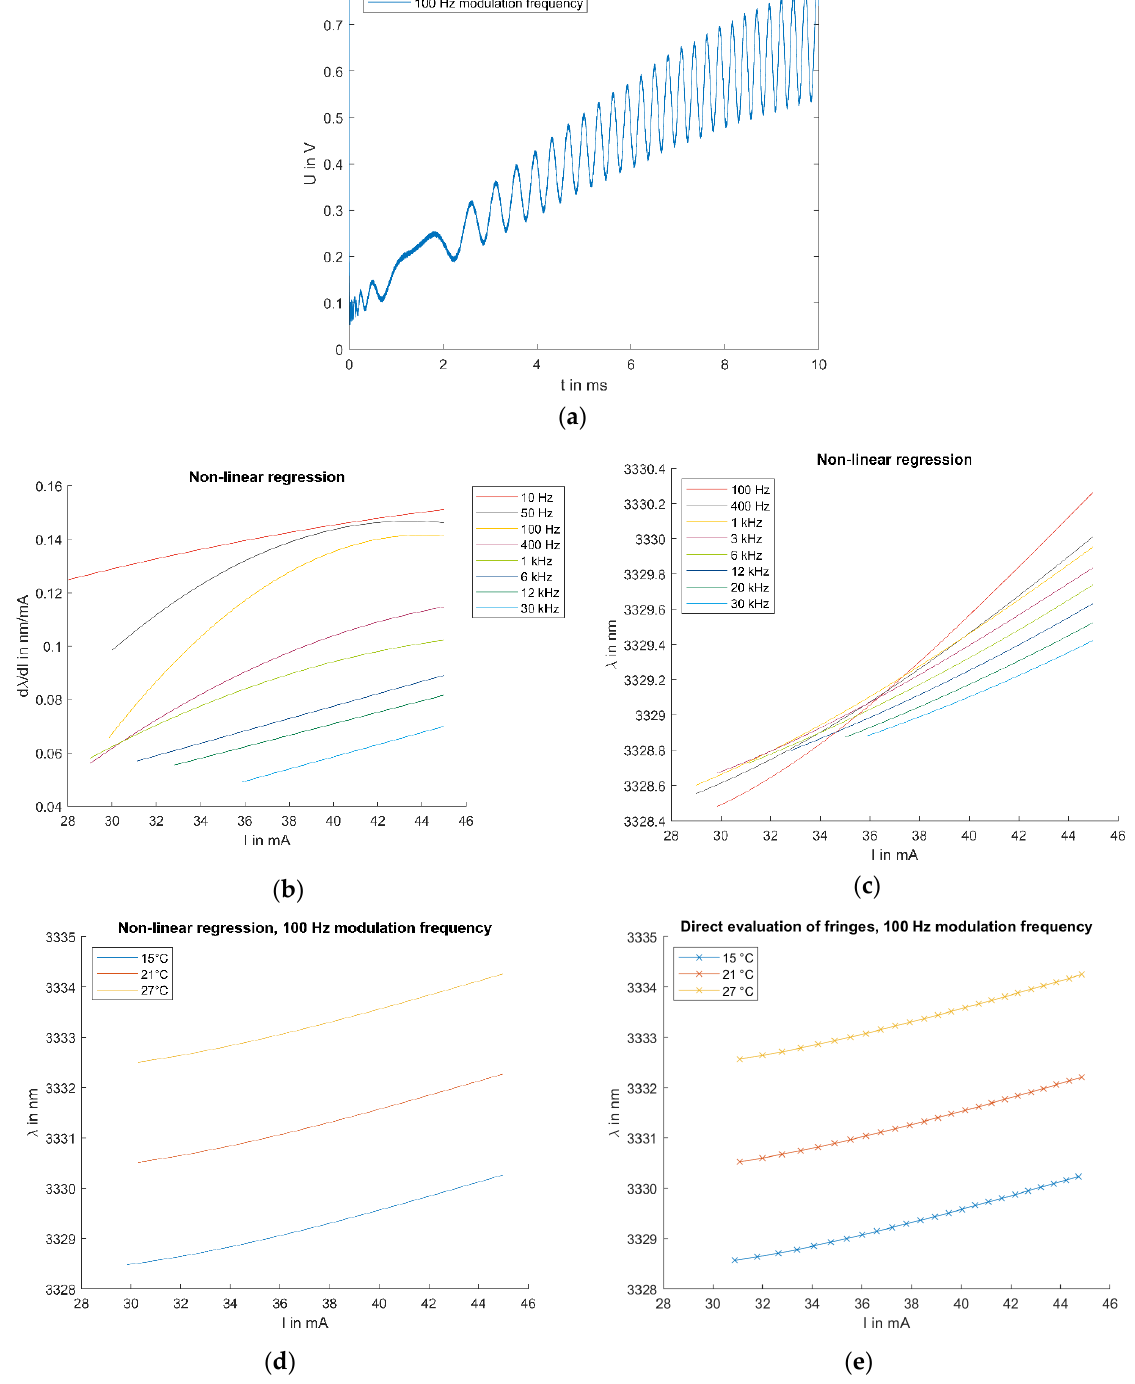
Figure 2. Measurements with the nanoplus ICL 1541 at sawtooth modulation: ( a ) Exemplary interference signal at 100 Hz modulation frequency and 15 °C laser temperature; ( b ) Change of wavelength as function of operating current for different modulation frequencies based on the non-linear regression method at 15 °C laser temperature; ( c ) Absolute wavelength as function of operating current for different modulation frequencies based on the non-linear regression method at 15 °C laser temperature; ( d ) Absolute wavelength as function of the operating current for three different laser temperatures based on the non-linear regression method at 100 Hz modulation frequency; ( e ) Absolute wavelength as function of the operating current for three different laser temperatures based on the direct evaluation of fringes at 100 Hz modulation frequency; the crosses mark the calculation points.